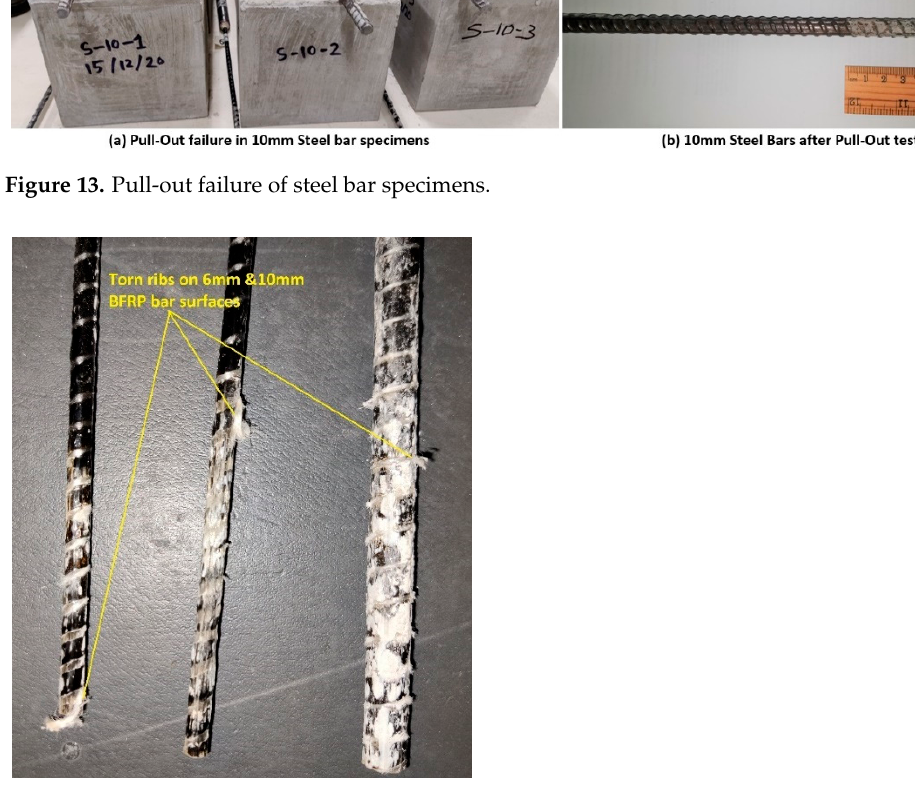
Figure 15. Cross-sectional view of cut Pull-out specimens.